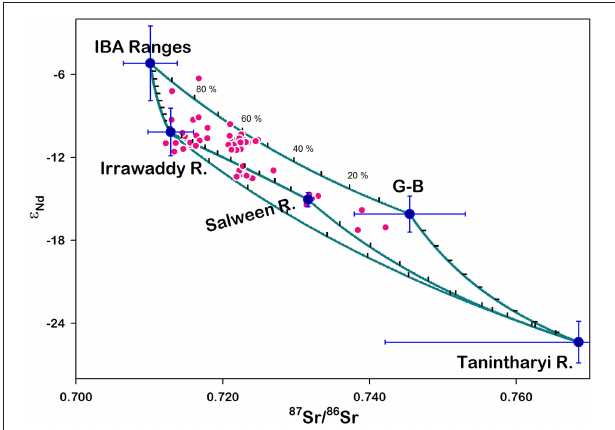
FIGURE 7 | Binary mixing plot of Sr and Nd isotope composition of the sediments of the Andaman Shelf. Sr and Nd isotope compositions of the potential end-members are also shown. For details about these end-members please see the text. This plot suggests that majority of the sediments to the Andaman Shelf are derived from the Irrawaddy river along with the Salween and rivers flowing through the western slopes of the Indo–Burman–Arakan and Western/Central granitic ranges. Blue curve represents the hyperbolic two end member mixing curve where as ticks on them indicate the fractions of the end